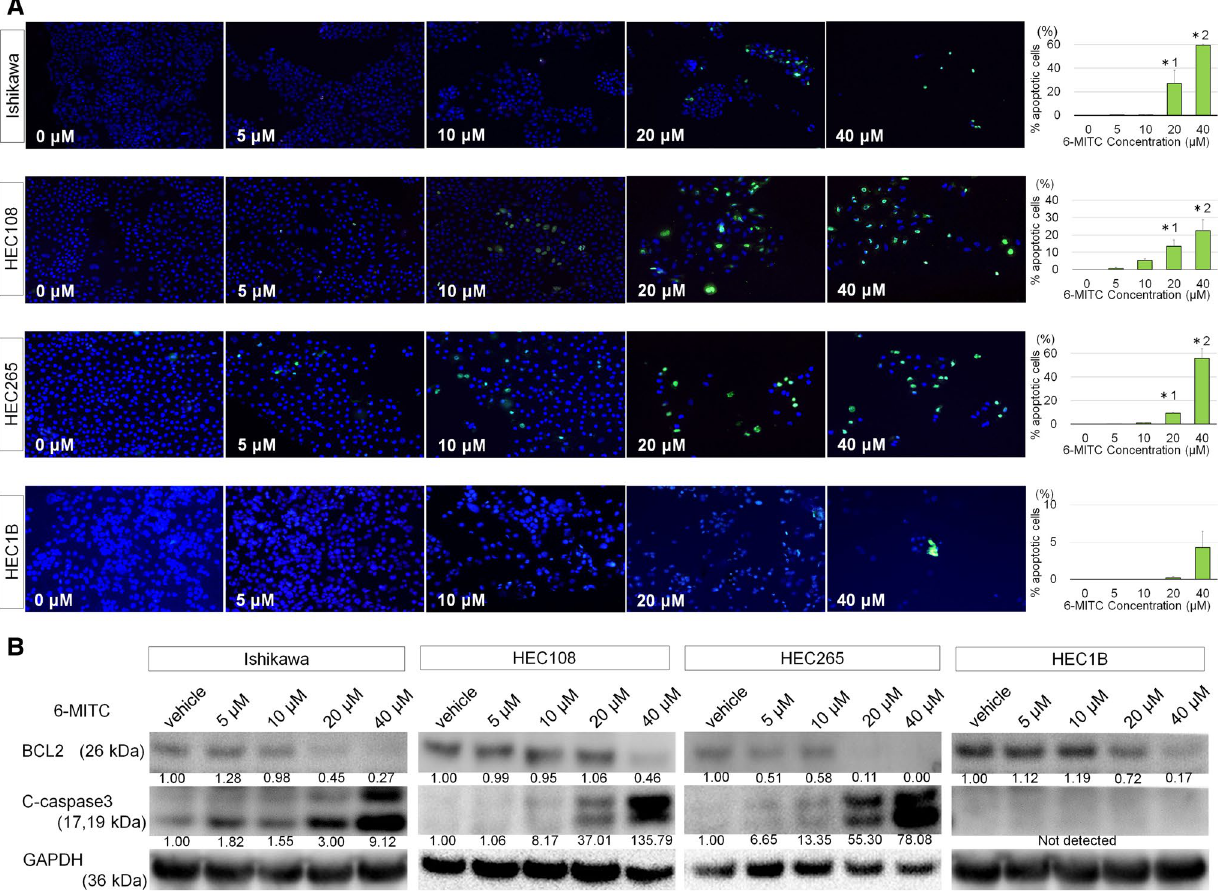
Fig. 2 A Effect of 6-MITC on apoptosis in EMC cell lines. Pictures show apoptotic cells with green or yellow fluorescence. Graphs indicate mean values of the percentage of apoptotic cells of 100 (40 µM of 6-MITC) to 1000 cells in three independent experiments, and error bars indicate the standard deviations. 6-MITC induces apoptosis in Ishikawa, HEC108, and HEC265 cells, dose-dependently. However, 6-MITC treatment does not increase apoptosis in HEC1B cells. *1 and *2 indicate significant differences compared with 0 µM, at p < 0.05 and p < 0.01, respectively. B Western blotting reveals that 6-MITC reduces the expression of anti-apoptotic proteins, BCL2, in EMC cell lines. Every numeri- cal value below the photographs is expressed as a ratio to the vehicle after quantifying the band density by densitometry and correcting it with GAPDH. 6-MITC enhances the expression of the proapoptotic protein c-caspase3 in Ishikawa, HEC108, and HEC265 cells but not in HEC1B